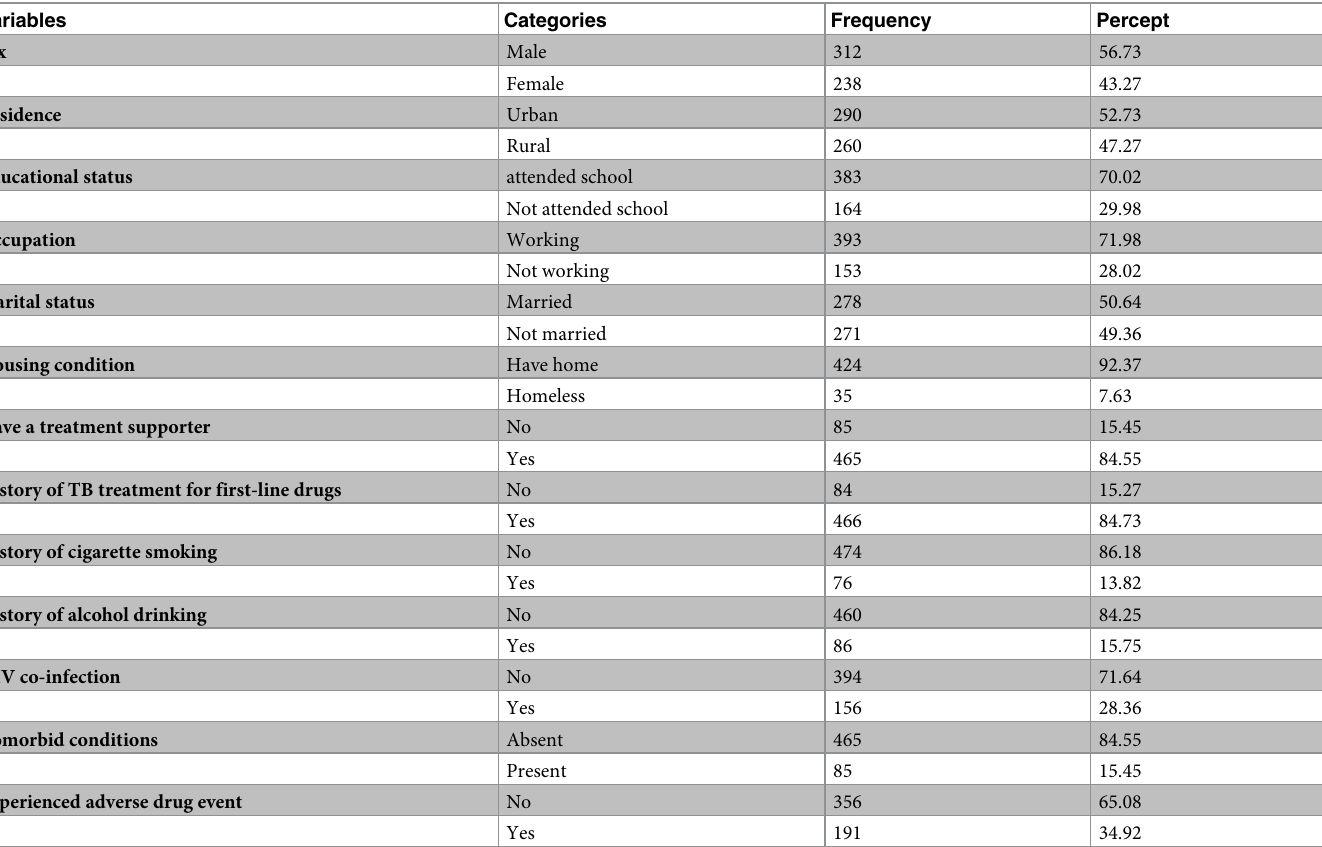
Table 1. Socio-demographic, treatment-related, behavioral, and clinical characteristics of DR- TB patients in Amhara regional state, Ethiopia: 2010–2017 (N = 550).